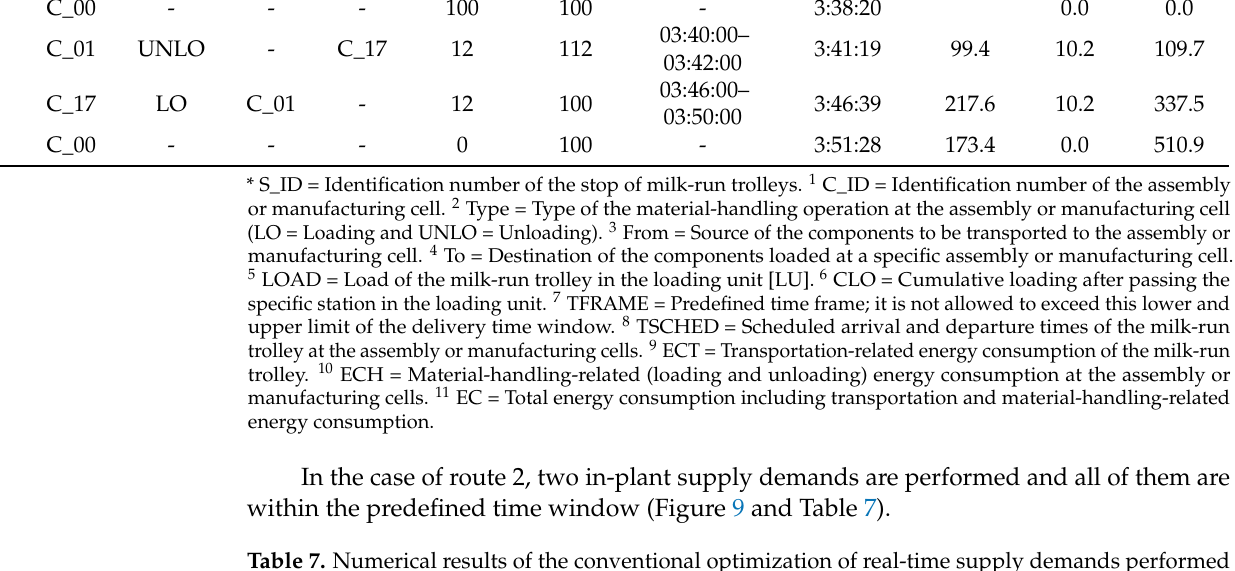
Table 7. Numerical results of the conventional optimization of real-time supply demands performed by the milk-run trolley within the additional route 5.